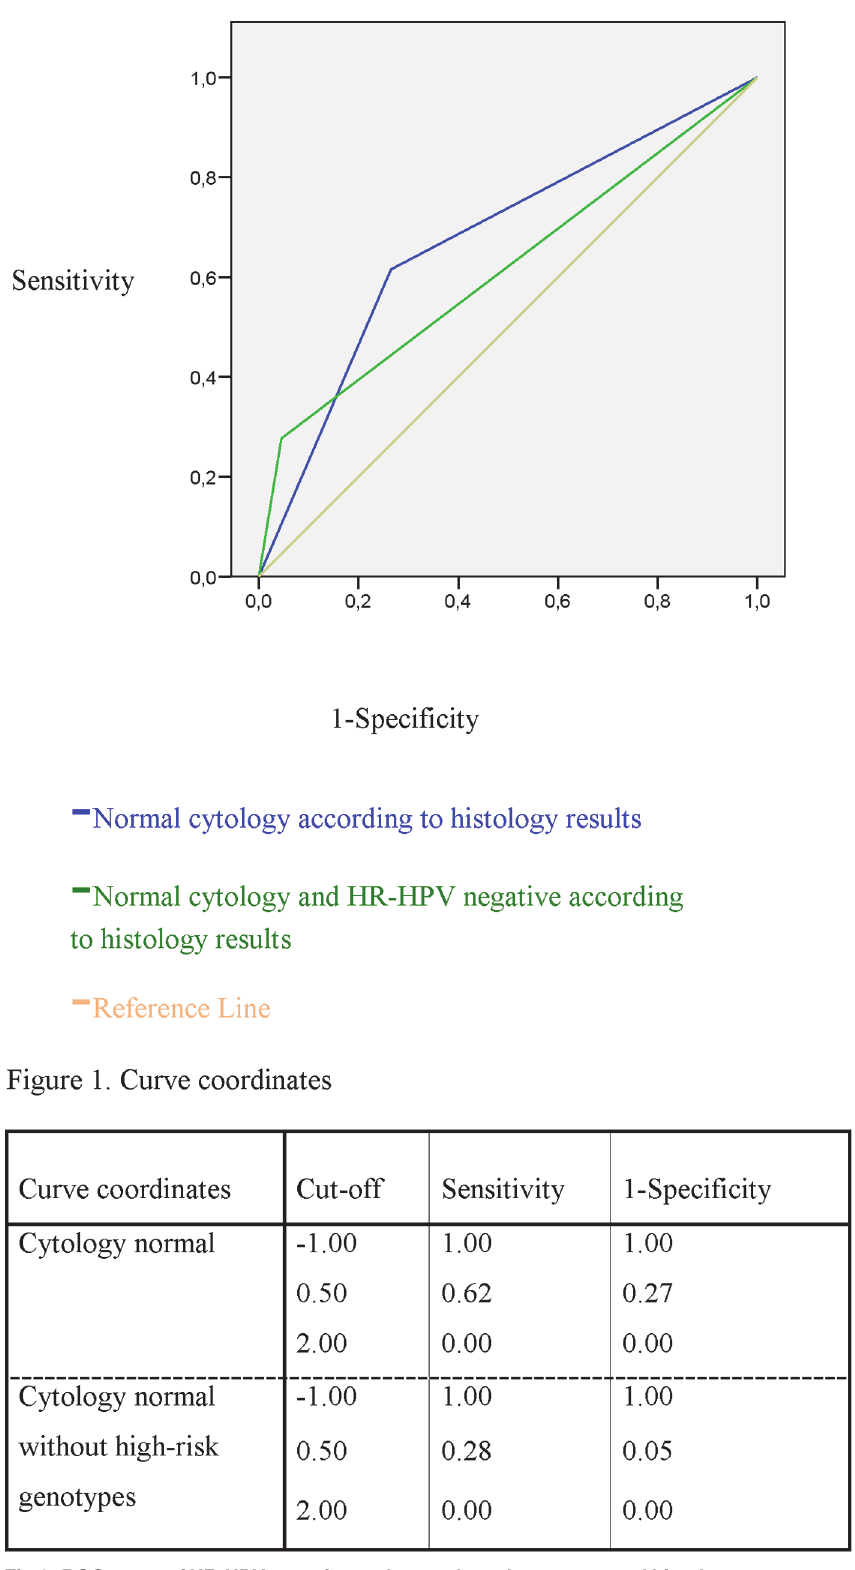
Fig 1. ROC curve of HR-HPV-negative and normal cytology vs . normal histology.